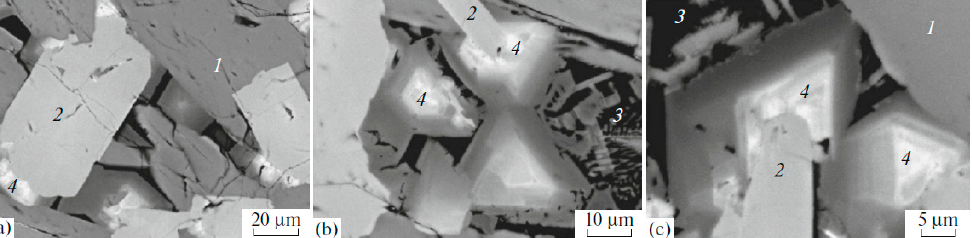
Figure 4. SEM images of the melted Synroc-type ceramic with model nuclear wastes: (1) hollandite, (2) zirconolite, (3) rutile and glass, (4) zoned murataite crystals overgrown on the zirconolite grains. ( a ) general view; ( b , c ) details with murataite–zirconolite intergrowths.